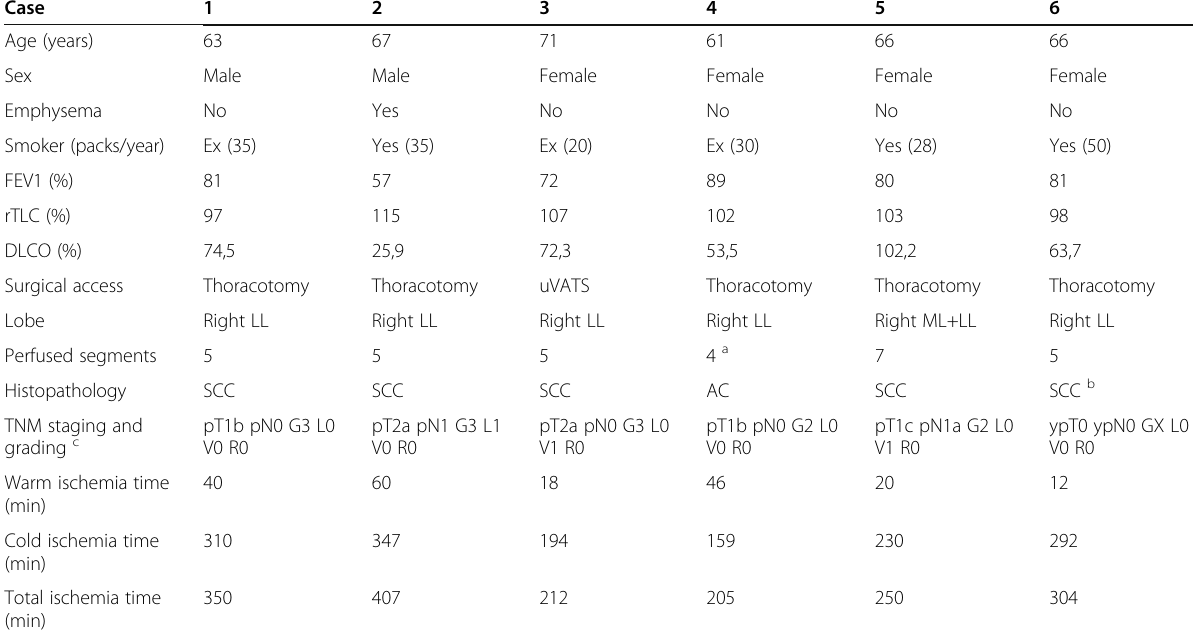
Table 1 Patient demography and oncological data of the investigated